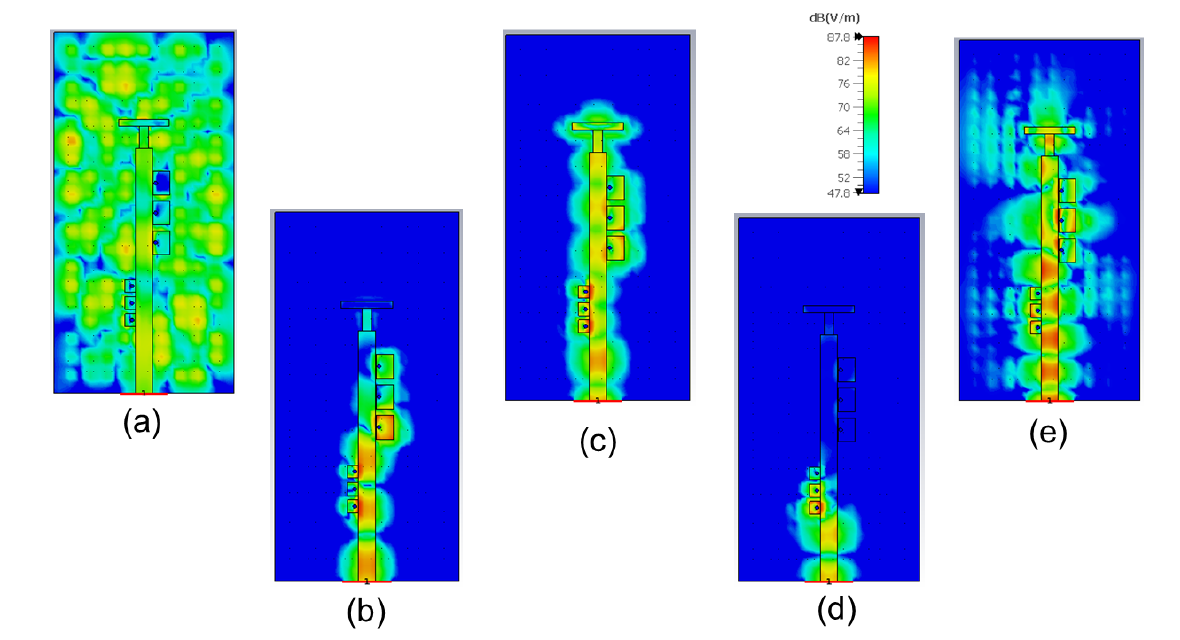
Figure 12. Electric field distribution | E z | for the filtering antenna at frequencies: ( a ) f = 7 GHz